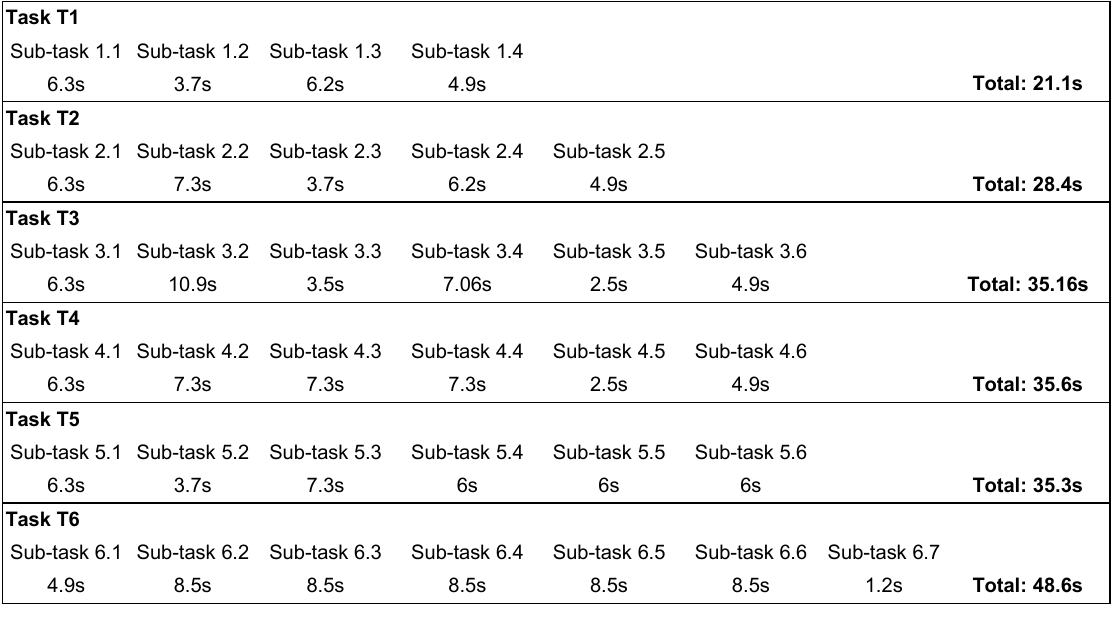
Table 2. Total time prediction for each